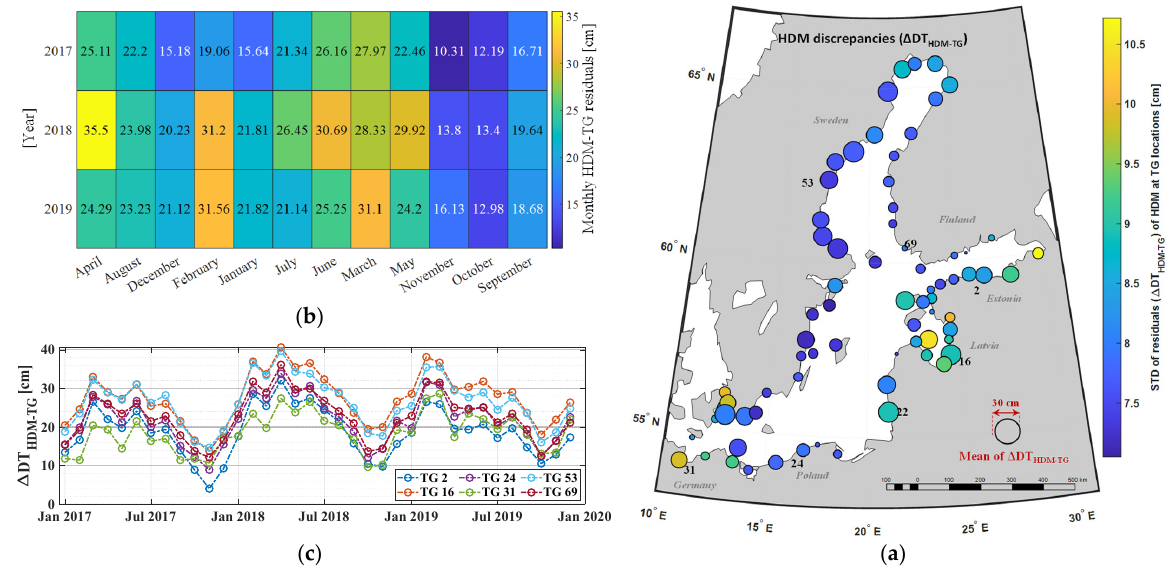
Figure 6. Statistics of HDM discrepancies with respect to participating TG stations. ( a ) Means (characterized by the circle size) and standard deviations (characterized by the colors) of discrepancies between HDM and TGs (Equations (16) and (17)) during 2017–2019 over the Baltic Sea. ( b ) Monthly average of HDM discrepancies over three years (Equation (16)). ( c ) Monthly average of HDM dis- crepancies at six selected TG locations (one station in each country with the largest STD or mean). TG IDs are explained in Figure 4a as well as in Table A1 (Appendix A). From Figure 6b,c, a seasonal pa tt ern of HDM discrepancies is observed. Figure 6c